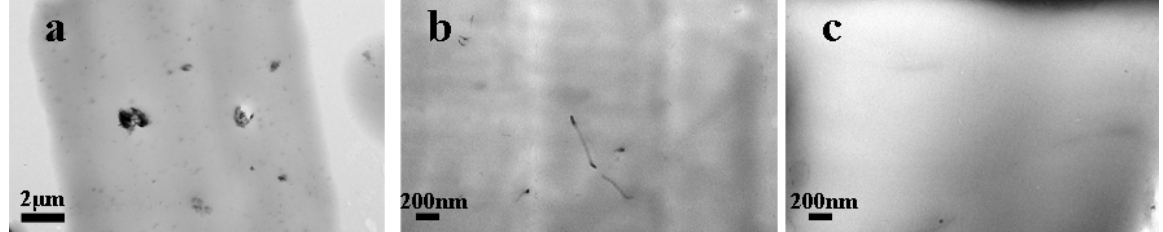
Figure 1. The transmission electron microscope (TEM) images of particles dispersed in polystyrene (PS). ( a ) 10% Lignin; ( b ) 0.2% multiwall carbon nanotube (MWCNT); ( c ) 1% mGr.